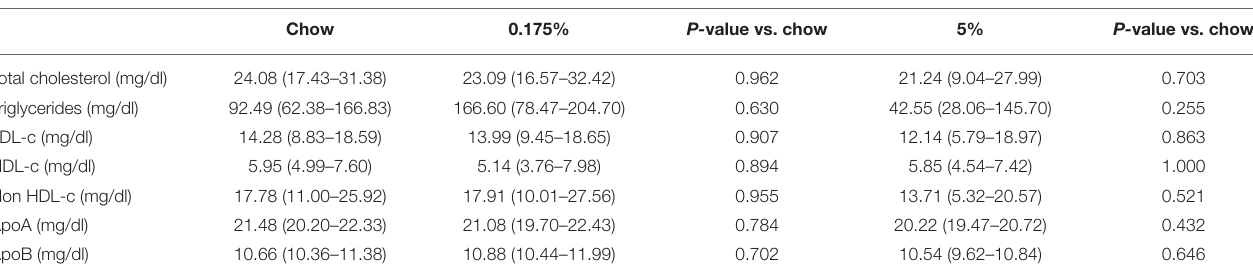
TABLE 3 | Effect of 0.175% lard and 5% lard diets on conventional lipid parameters. Chow 0.175% P- value vs. chow P- value vs.